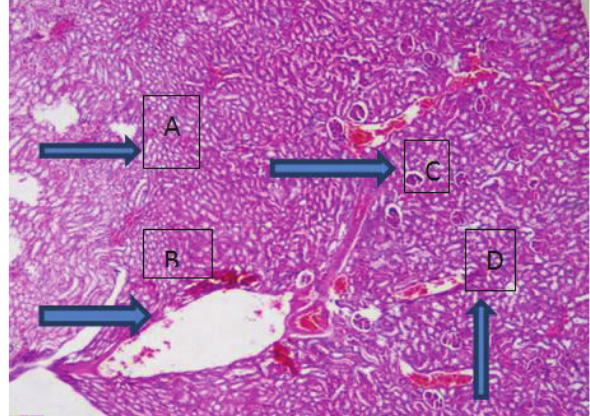
Fig-4: Showing damage of kidney in group 4 received extract of MO